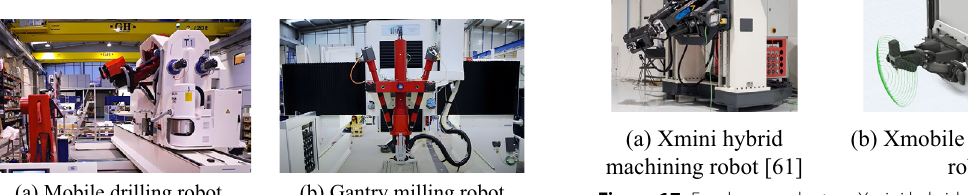
Figure 17 Exechon products: a Xmini hybrid machining robot [61]; b Xmobile mobile machining robot